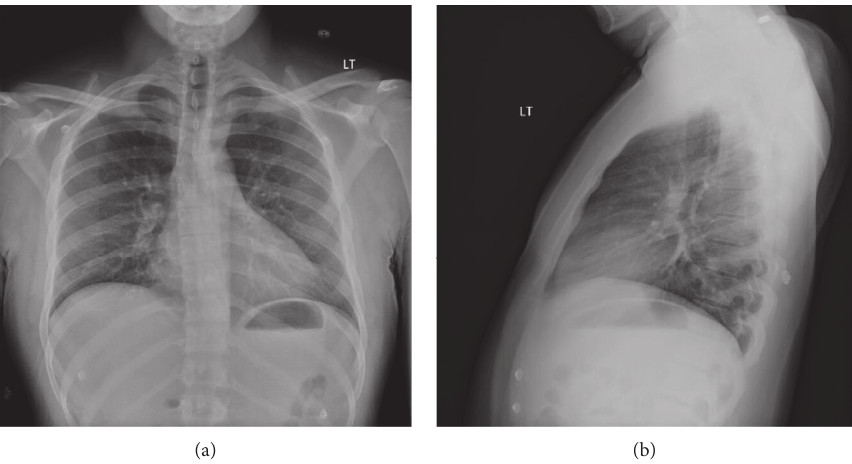
Figure 2: The patient’s chest X-ray: (a) PA and (b) lateral. The lungs demonstrated no focal consolidation to suggest pneumonia and no evidence of pulmonary edema, pleural effusion, or pneumothorax. The cardiac silhouette was noted to be within normal limits, and no free air was detected below the diaphragms.